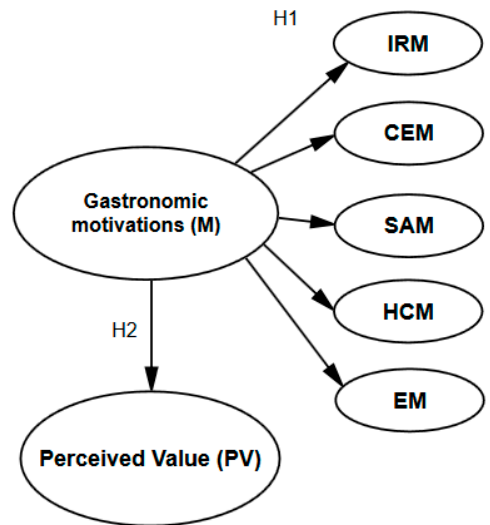
Figure 2. Hypothesis and relational model proposal. IRM: Interpersonal relationship motivations.